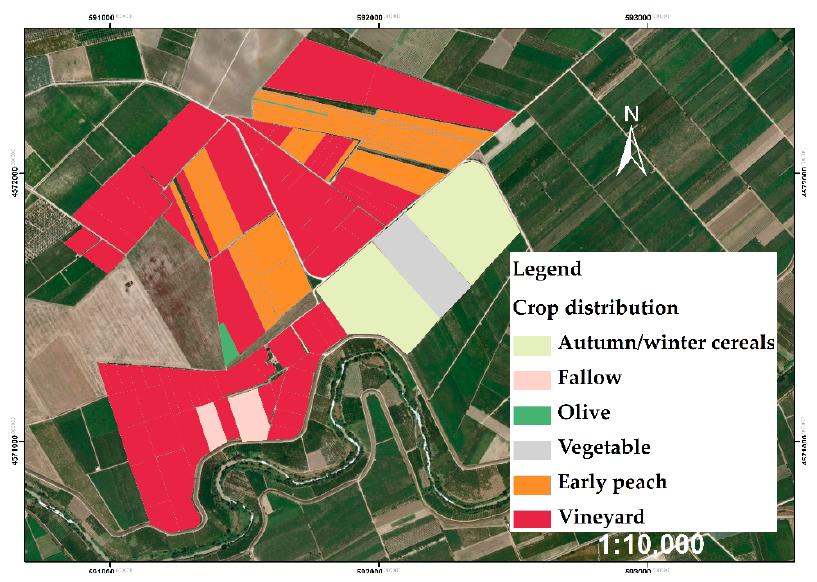
Figure 5. Cropping pattern map of Sector 6 of District 10 in the “Sinistra Ofanto”. Table 2. Crop water consumption for the year 2016 (Source: CBC).